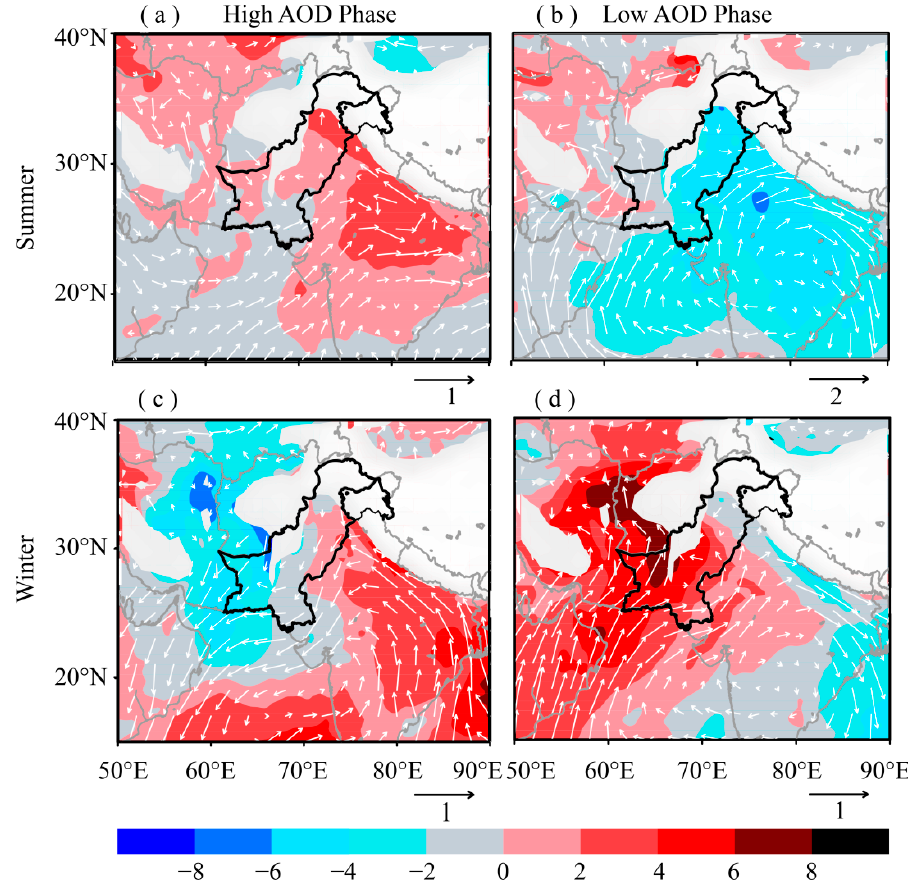
Figure 11. Anomalous wind speed (vectors) (m s − 1 ) and relative humidity (shaded) at 850 hPa for high and low AOD years during summer ( a , b ) and winter ( c , d ) seasons. The arrows below the graphs give the reference for the anomalous wind speed (in ms − 1 ). Locations where the surface geopotential height is higher than the 850 hPa geopotential height have been masked out. The region surrounded by the dark boundary line represents the study area.